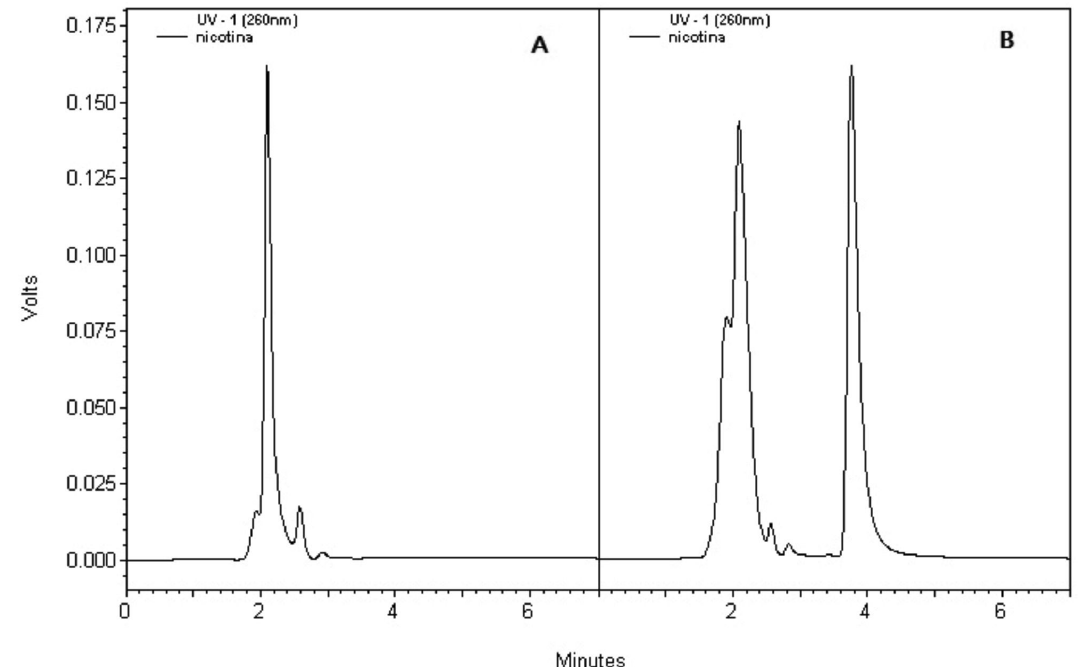
FIGURE 1 - Chromatograms of blank (A) and nicotine (B) extracted from excised skin samples (retention time of nicotine was approximately 4 minutes) TABLE II - Precision and accuracy of analytical method Concentration ( µg mL -1 )